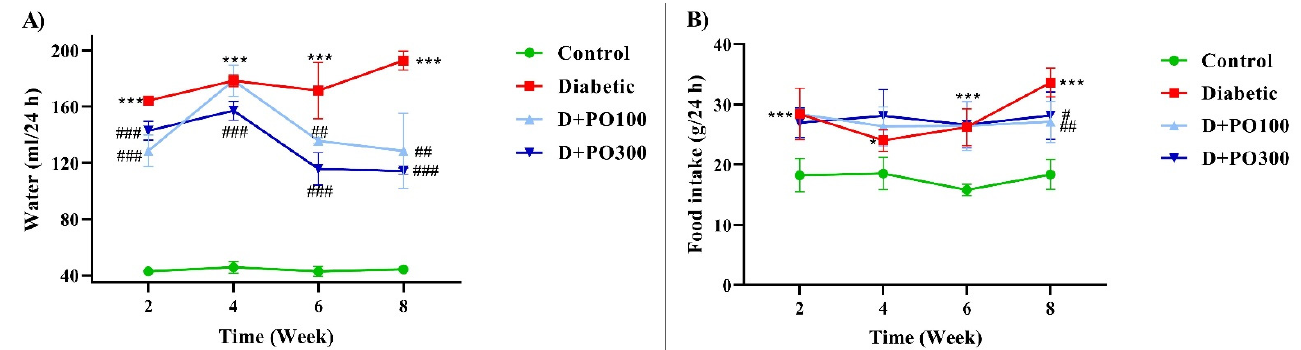
Figure 2. The effects of PO extract on ( A ) water and ( B ) food consumption in diabetic rats. The data are presented as mean ± SD. Repeated measures two-way ANOVA test was carried out with the following Tukey–Kramer’s post hoc test; *** p < 0.001 vs. control group; # p < 0.05, ## p < 0.01, ### p < 0.001 vs. diabetic group.